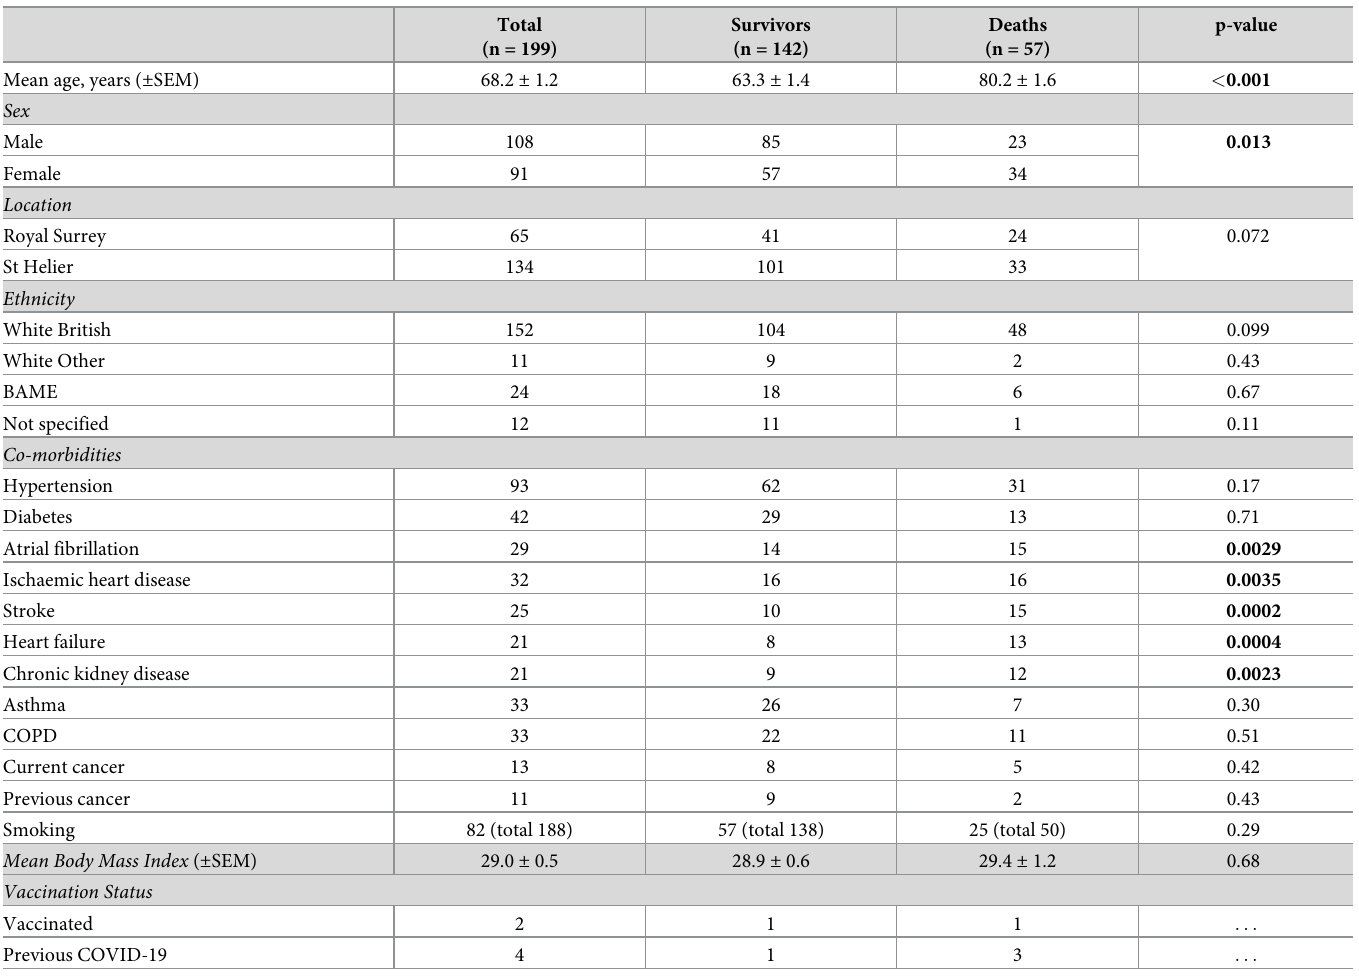
Table 1. Baseline demographic and clinical parameters.